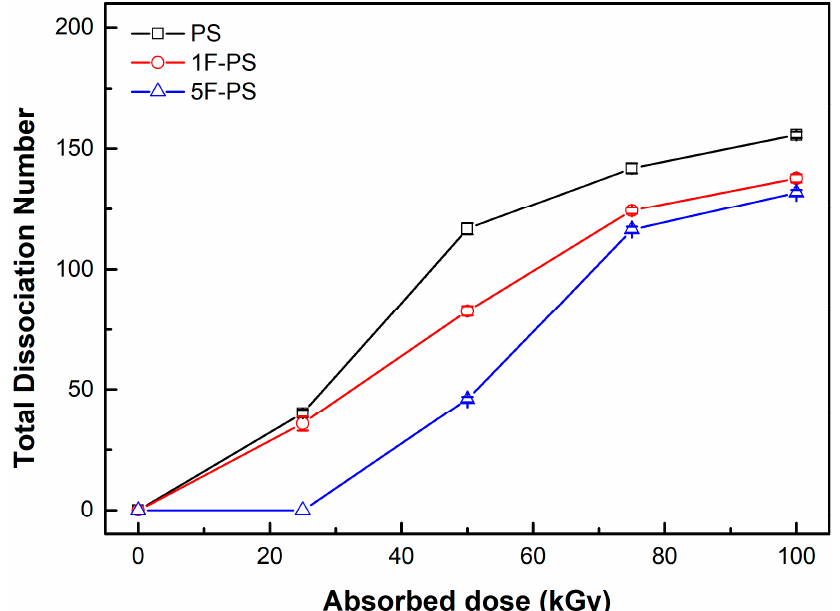
Figure 8. Total dissociation number of polymers.